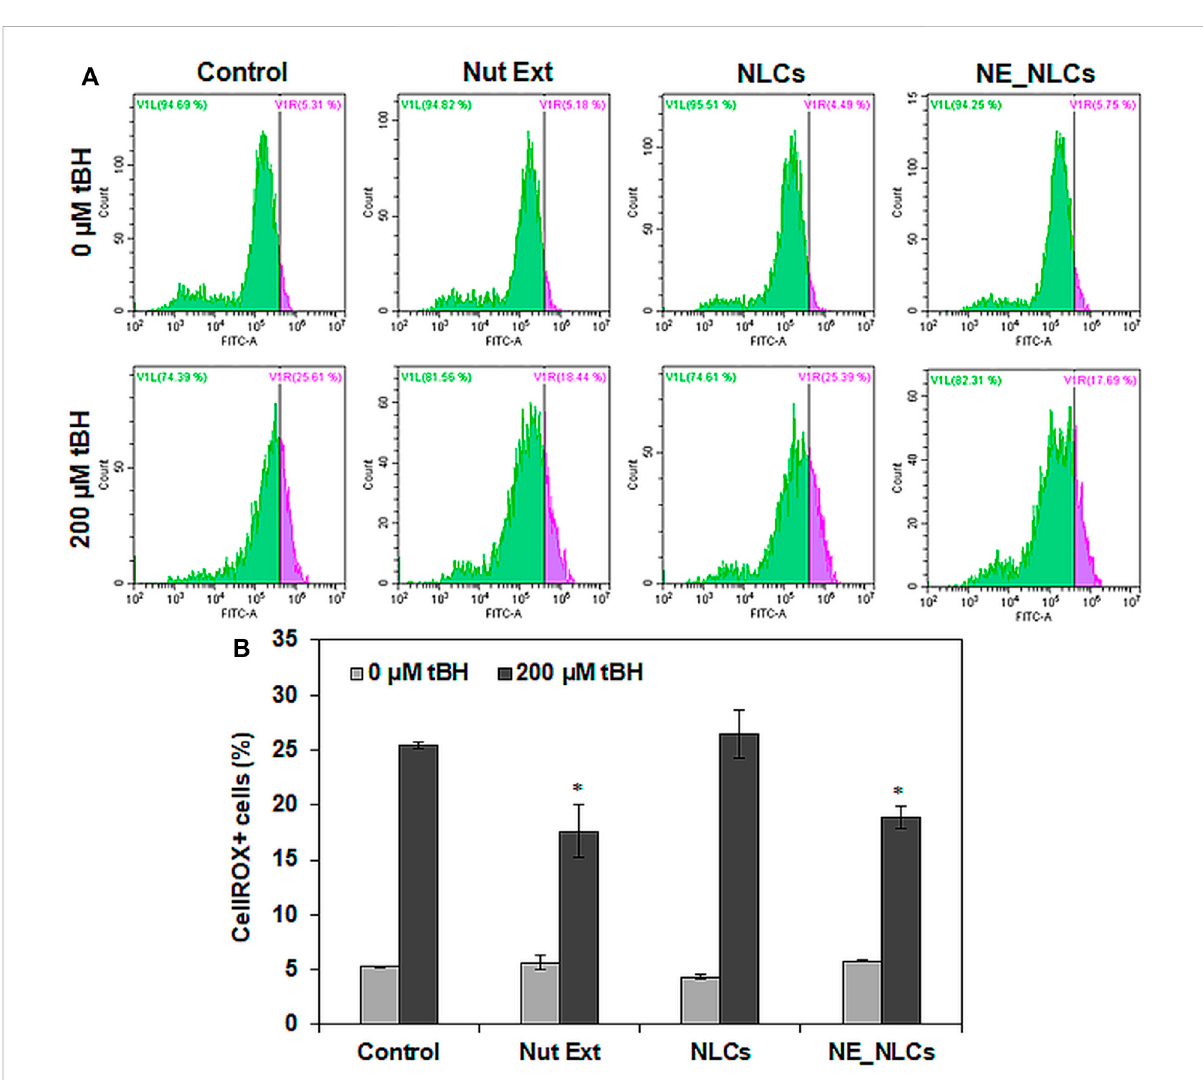
FIGURE 5 Levels of reactive oxygen species (ROS) in HDFs after 24 h of the indicated treatments (NE_NCLs 100 μ g/ml, Nut Ext 70 μ g/ml): representative scatter plots (A) and quantitative analysis (B) . Data are represented as mean values ±standard deviation ( n = 3; * p < 0.05).